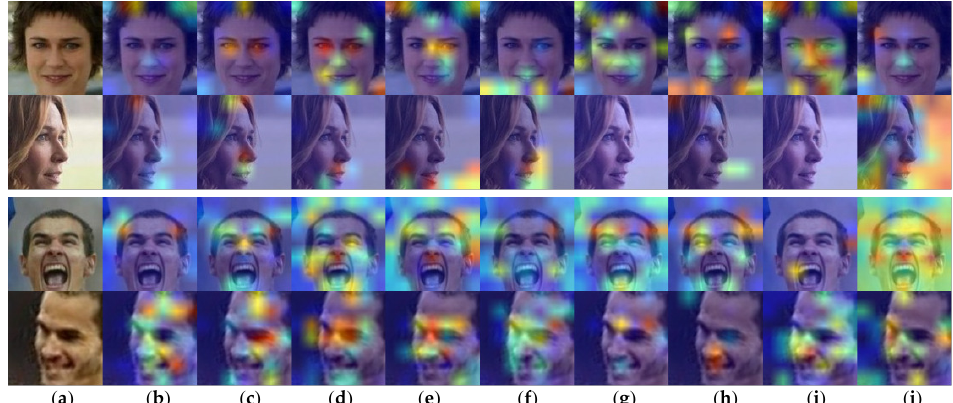
Figure 9. Two random face image pairs from the CPLFW dataset. The original image pairs are shown in ( a ), and the corresponding Grad-CAM visualisations for ConvFaceNeXt family members are illus- trated from ( b ) to ( e ), while for the other previous works are shown from ( f ) to ( j ), with all arranged column-wise left to right. ( a ) Original face image pairs. ( b ) ConvFaceNeXt_PS. ( c ) ConvFaceNeXt_PE. ( d ) ConvFaceNeXt_TS. ( e ) ConvFaceNeXt_TE. ( f ) MobileFaceNet [11]. ( g ) ShuffleFaceNet 1 × [12].